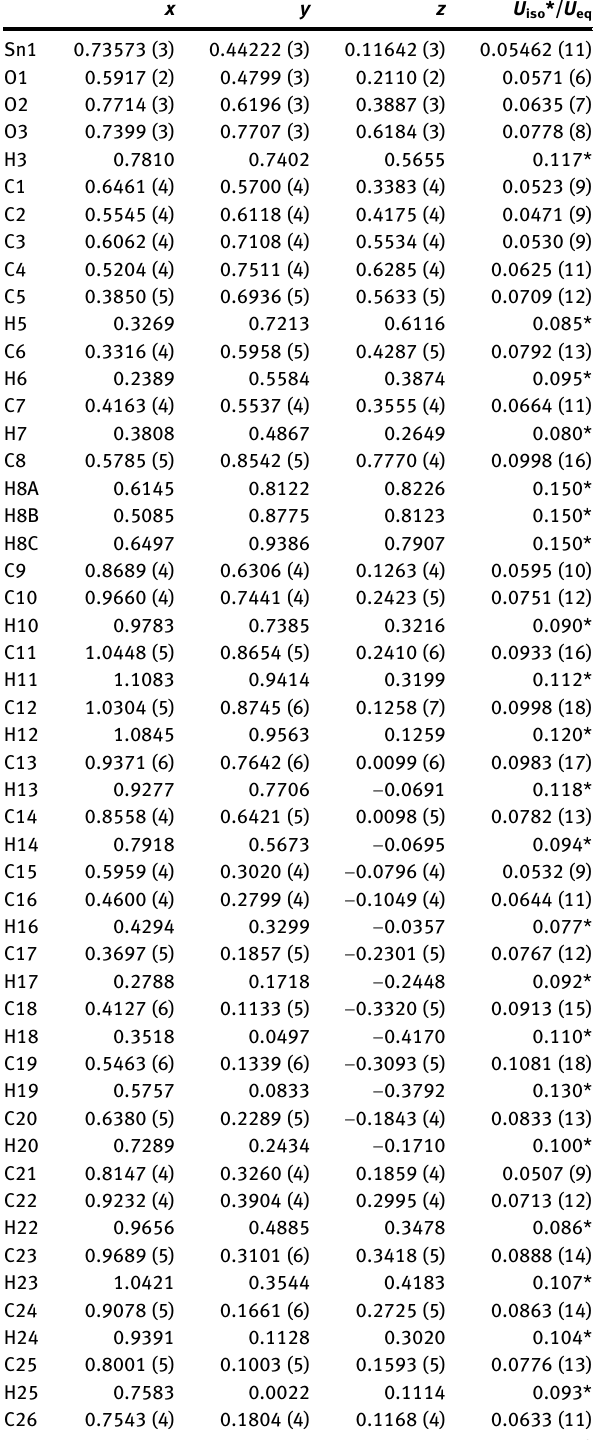
Table  : Fractional atomic coordinates and isotropic or equivalent isotropic displacement parameters (Å 